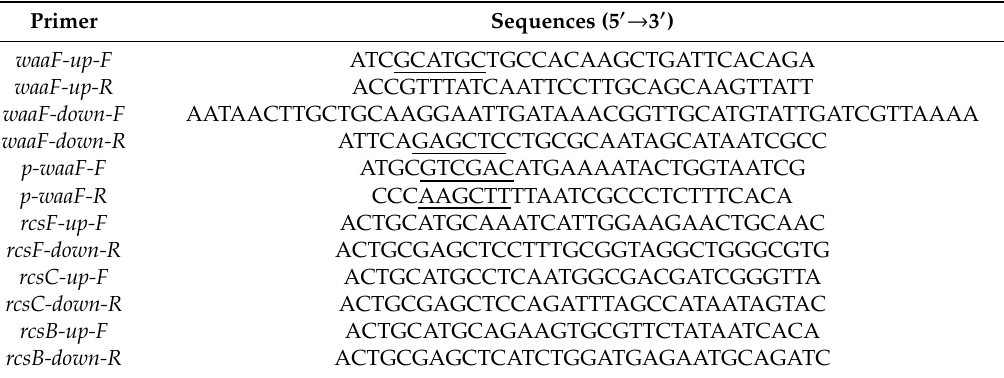
Table 2. Primers used for strain and plasmid construction in this